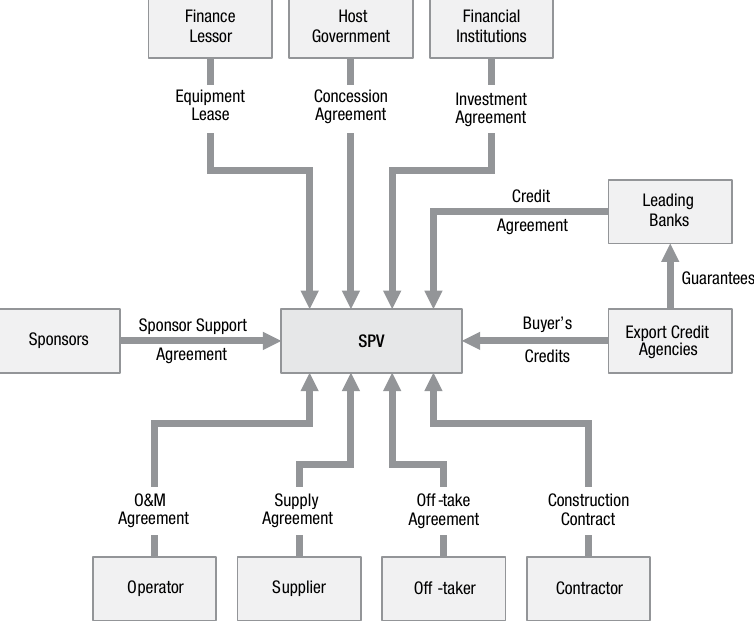
Fig. 1. SPV and its agreements with various parties Source : Sapte